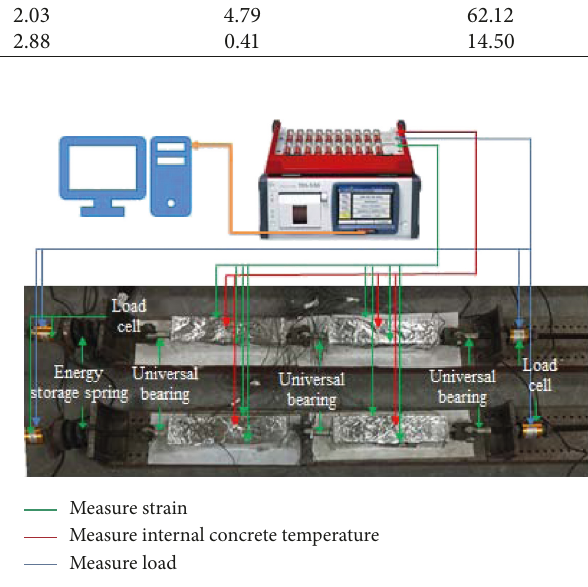
Figure 3: Tensile creep measurement